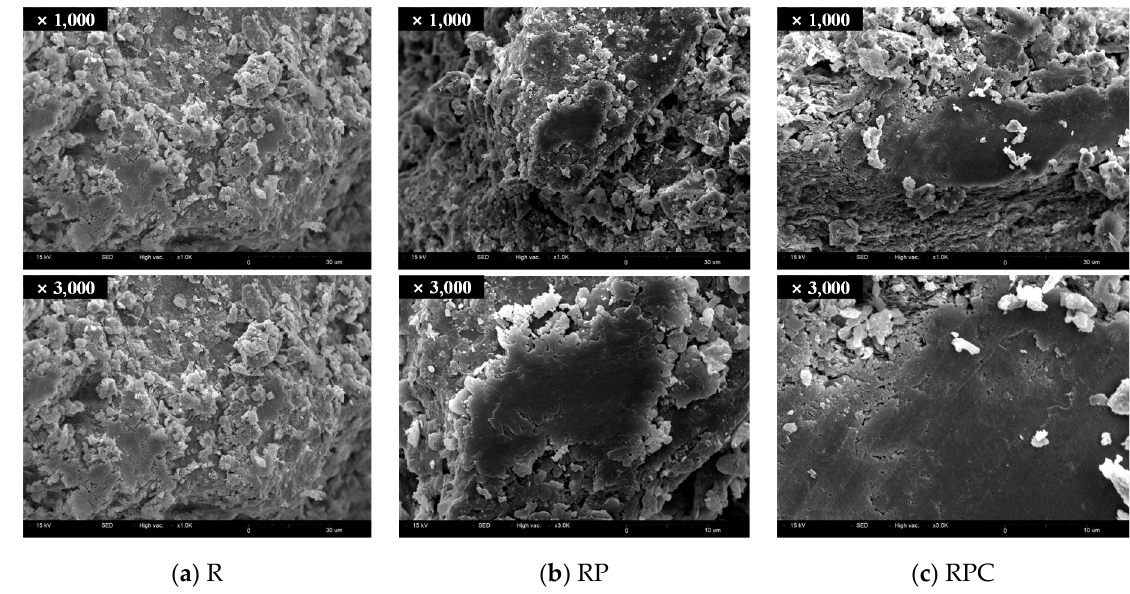
Figure 11. Scanning electron microscopy micrographs of specimens of 28 days age.